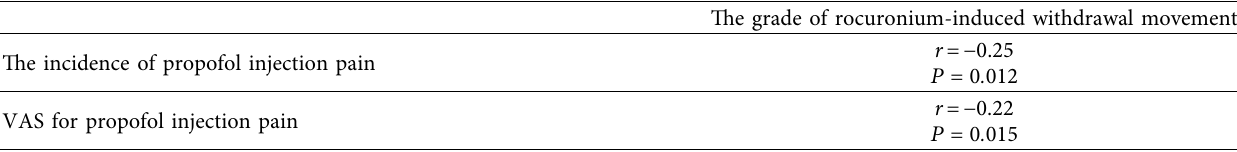
Table 3: The correlation between propofol injection pain and the grade of rocuronium-induced withdrawal